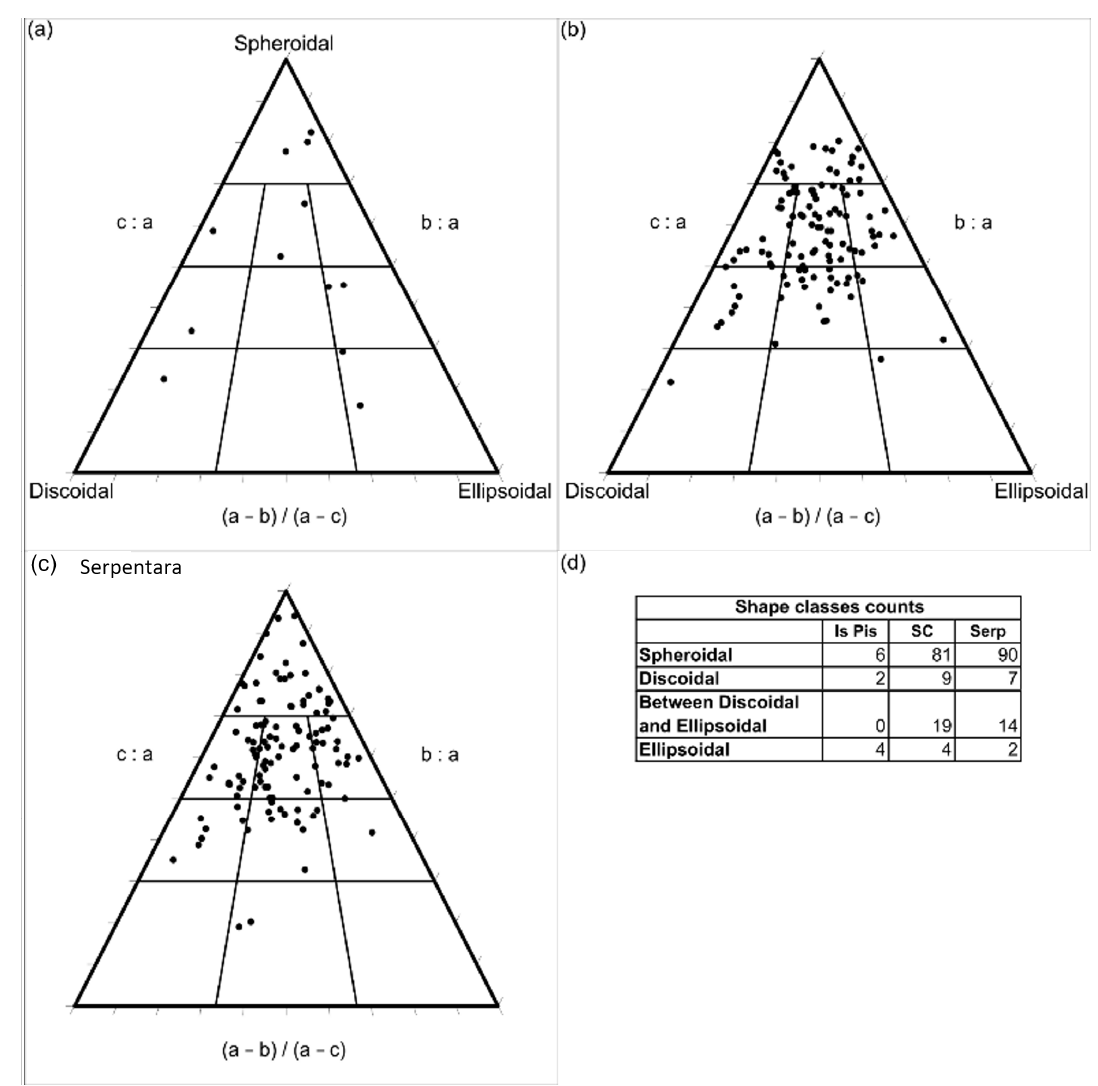
Figure 5. ( a ) Is Piscadeddus, ( b ) Santa Caterina, and ( c ) Serpentara ternary plots of boxwork and praline shape: a = long axis, b = intermediate axis, and c = short axis. ( d ) counting the number of specimens per shape. Is Pis is for Is Piscadeddus, SC for Santa Caterina and Serp for